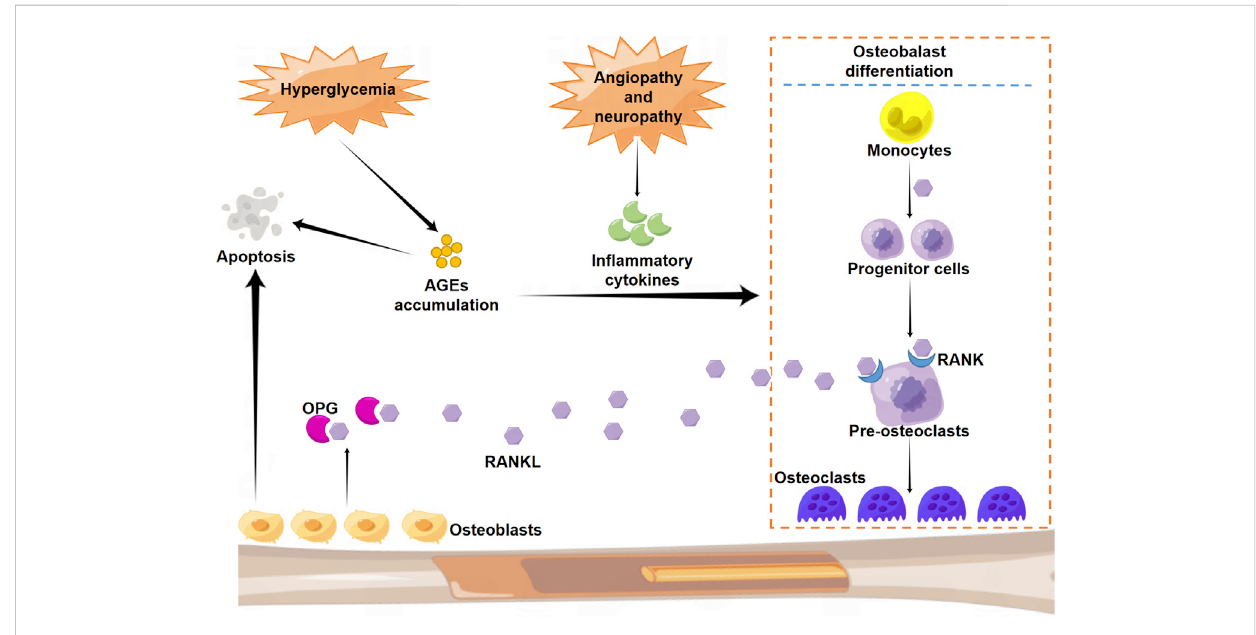
FIGURE 2 Schematic illustration of the molecular mechanism of osteoclast differentiation. RANK: nuclear factor- κ B; RANKL: RANK